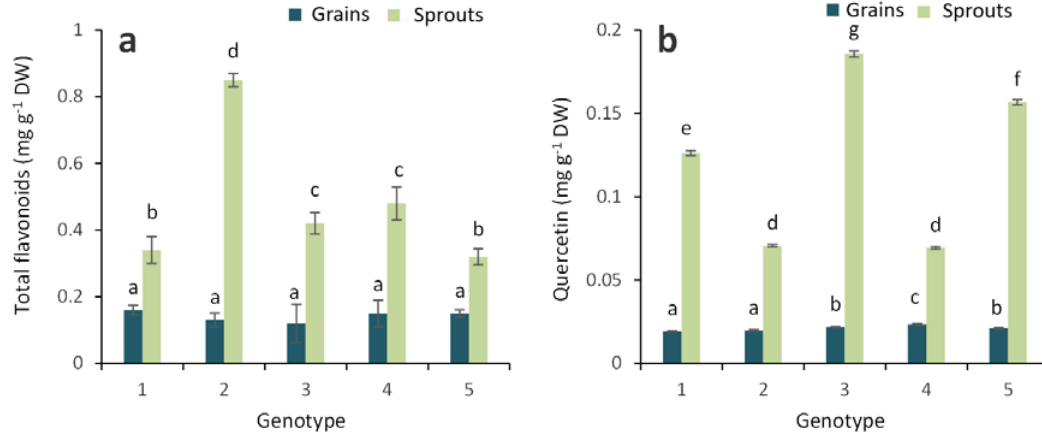
Figure 3. Total flavonoids ( a ) and quercetin ( b ) in the grains and sprouts of colored wheat genotypes. 1—Citrus yellow, 2—KM 53-14 Blue, 3—KM 178-14 purple, 4—Skorpion Blue aleurone, 5—PS Karkulka purple. The columns represent the mean values ± S.E. for five replicates. Statistically significant differences among treatments at each time are indicated by different lowercase letters (Duncan test; p < 0.05).